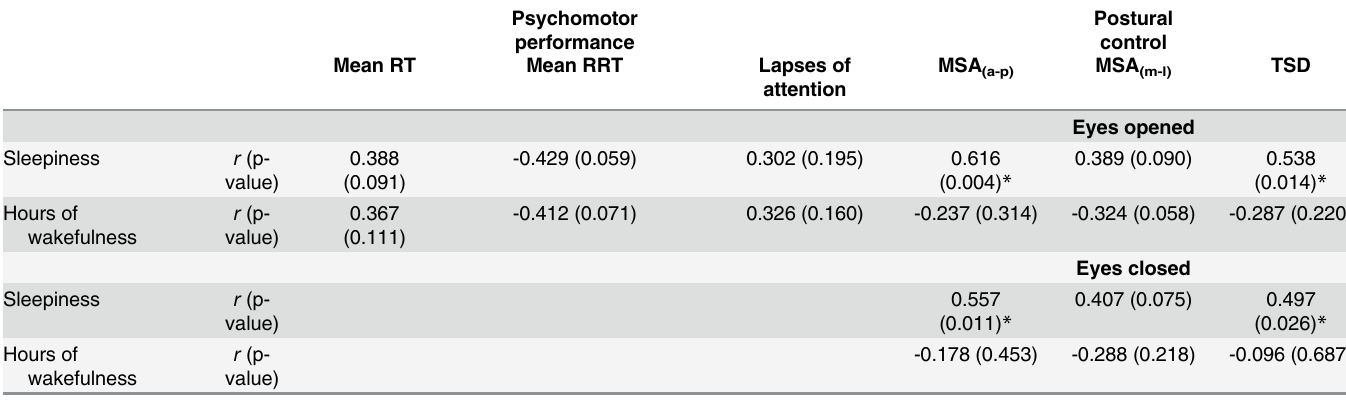
Table 2. Correlation coefficients ( r ) of sleepiness and hours of wakefulness for the variables related to psychomotor performance and postural control (n =